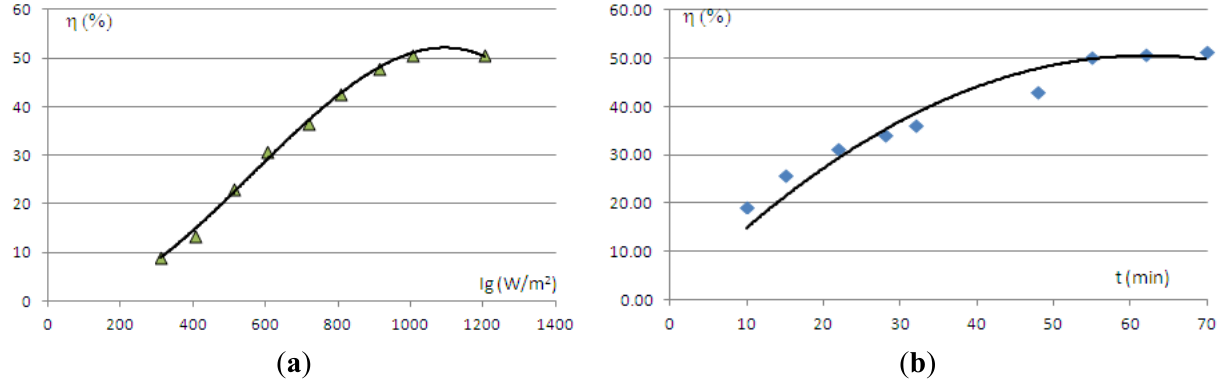
Figure 7. Efficiency of solar air collector versus ( a ) solar radiation I